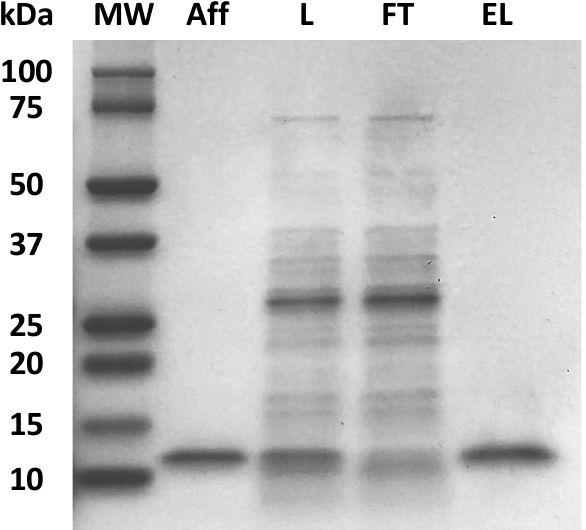
Figure 2. SDS-PAGE (non-reducing conditions, Coomassie staining) of flow-through (FT) and elution (EL) fractions obtained by purifying anti-ErbB2 affibody from a clarified E. coli cell lysate using a column packed with IGKQRI–GSG–Toyopearl resin. Labels: MW, molecular weight marker; L, load; UB, unbound; EL, elution at pH 3.8; Aff, affibody standard.